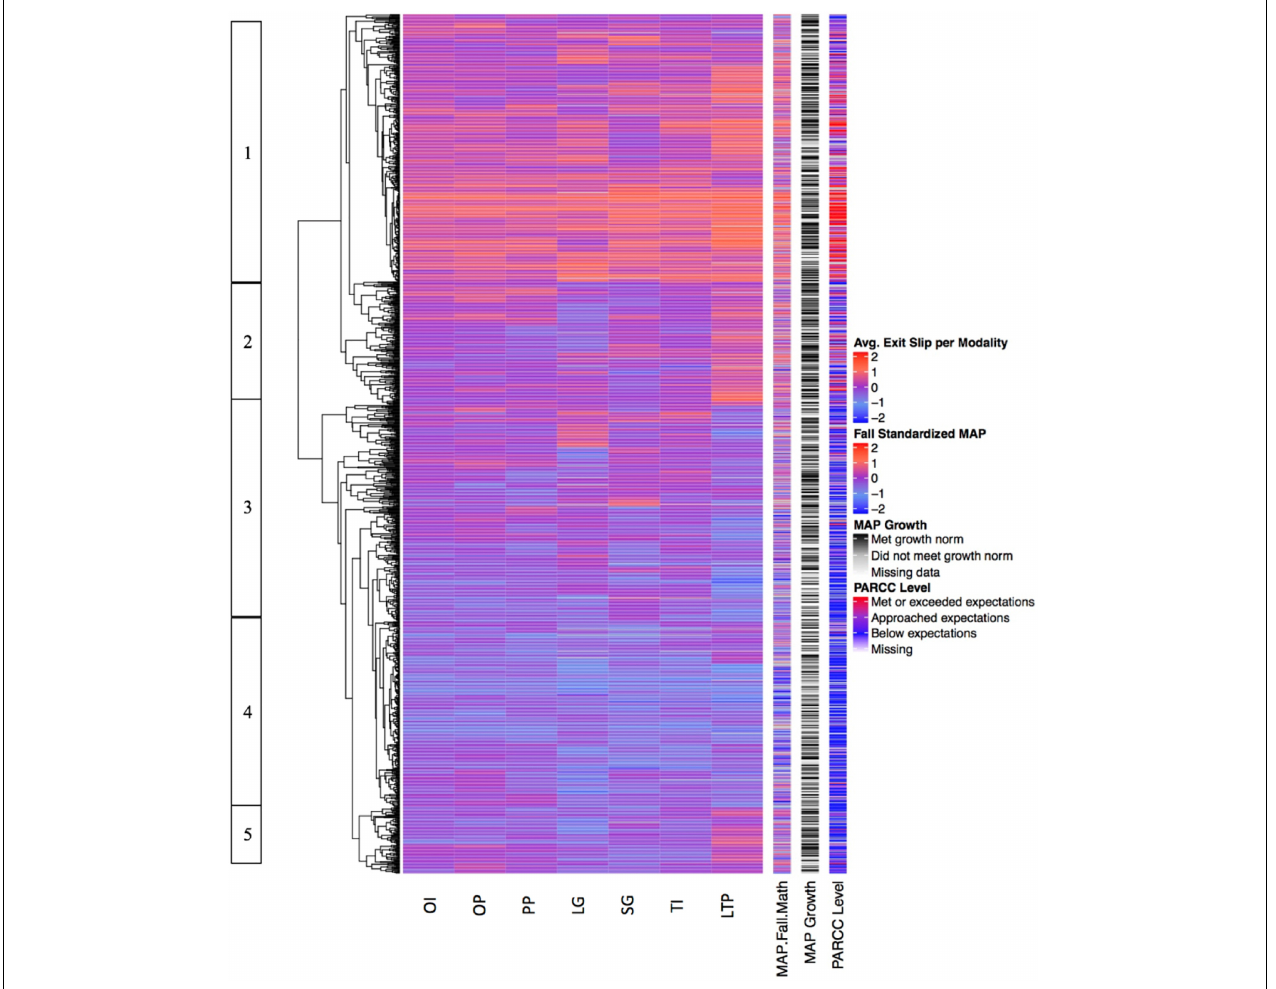
FIGURE 2 | Standardized exit slip performance disaggregated by instructional